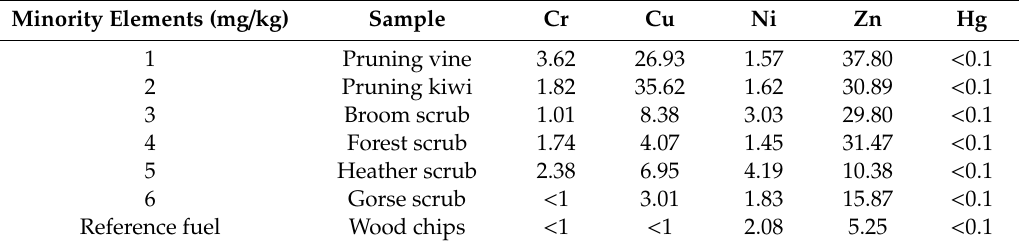
Table 5. Minority elements.